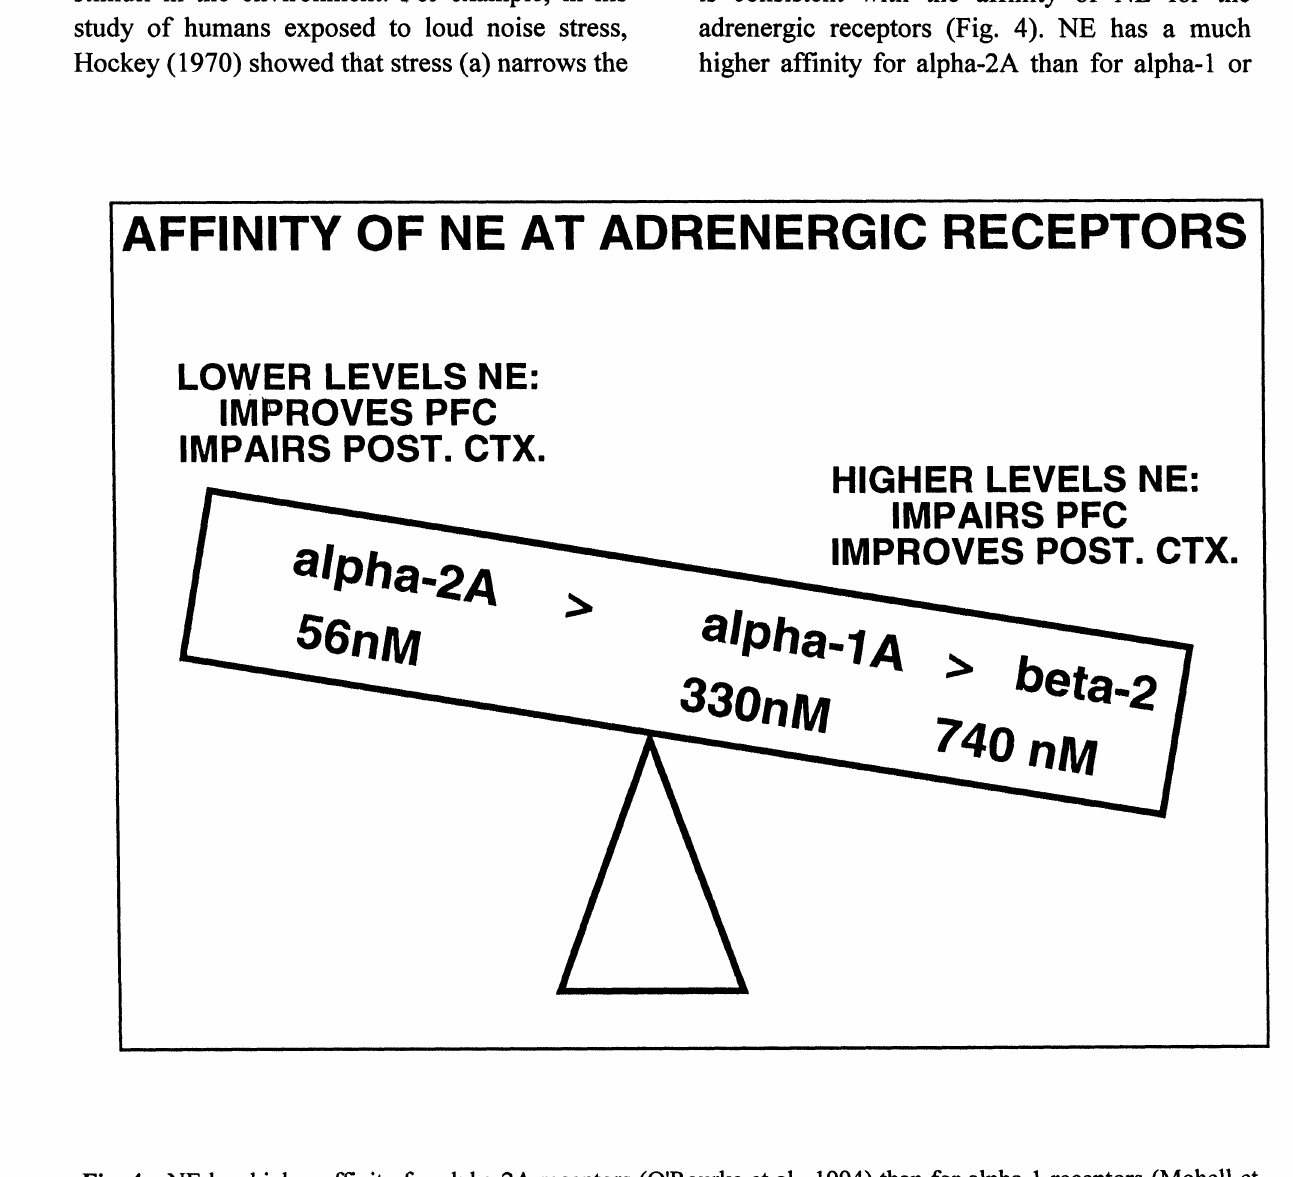
Fig. 4: NE has higher affinity for alpha-2A receptors (O’Rourke et al., 1994) than for alpha-1 receptors (Mohell et al., 1983) or beta receptors (Pepperl & Regan, 1994). Thus, lower, basal levels of NE release may engage alpha-2A receptors and facilitate PFC function, while high levels of NE release during stress may be needed to engage alpha-1 receptors and impair PFC function. Conversely, high levels of NE engaging alpha-1 and beta receptors would enhance the functions ofthe amygdala, hippocampus, and posterior